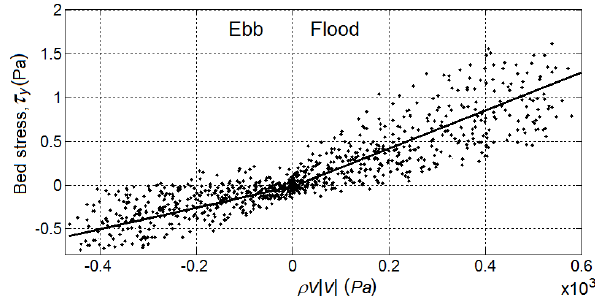
Fig. 11. Along-shore velocity squared at 2 mab versus Reynolds stress averaged within the bottom layer, 1.5-4.0 mab. Both quantities are 10-min averaged. Linear fit for the flood flow yields a drag coefficient of 0.0022 whereas for the ebb flow the fit yields a drag coefficient of 0.0012.